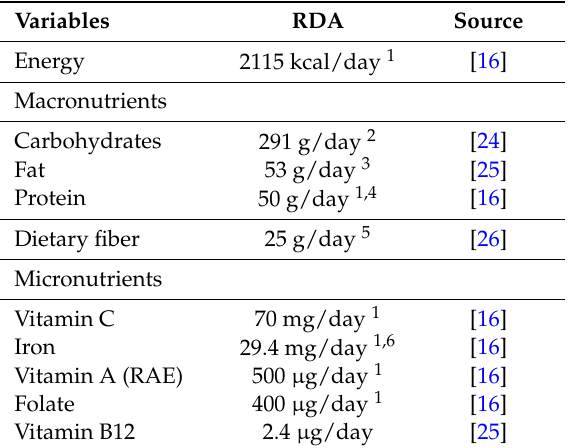
Table 4. Recommended dietary allowances (RDAs) for energy, macronutrients, dietary fiber, VitC, iron, VitA, folate and VitB12 among non-pregnant women aged 19–30 years